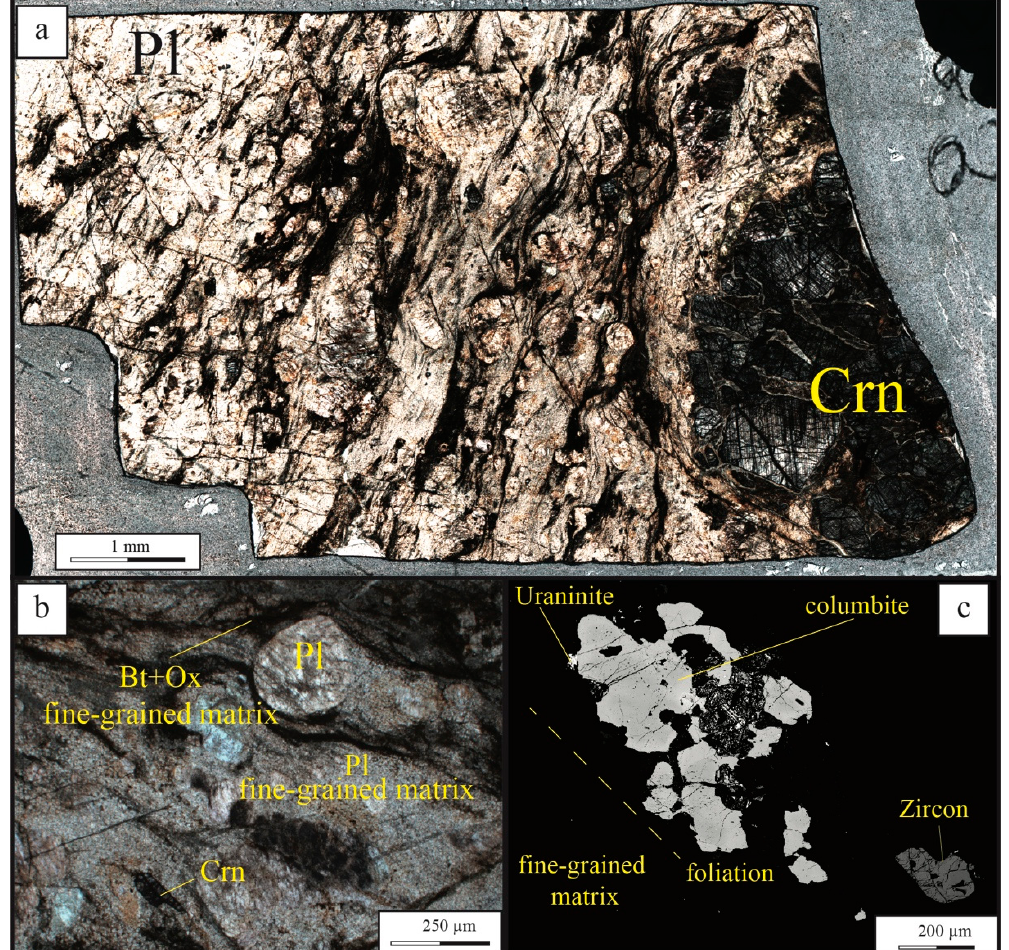
Figure 4. ( a ) scan of SB08 thin section (80 μ m thick) showing the porphyroclastic texture. ( b ) microphotograph of plagioclase porphyroclasts embedded within the fine-grained matrix consisting mainly of plagioclase, oxide, biotite and corundum. ( c ) SEM-BSE image acquired with high contrast and low brightness showing columbite, zircon and uraninite within the fine-grained matrix.